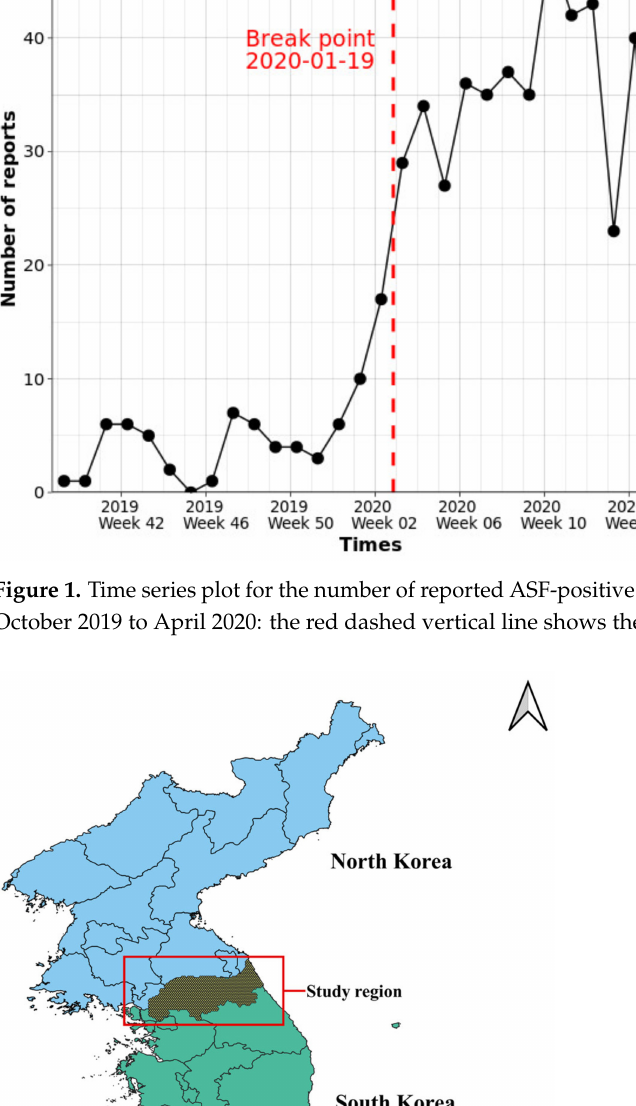
study sites and were marked using the second-level administrative regional (si-gun-gu)